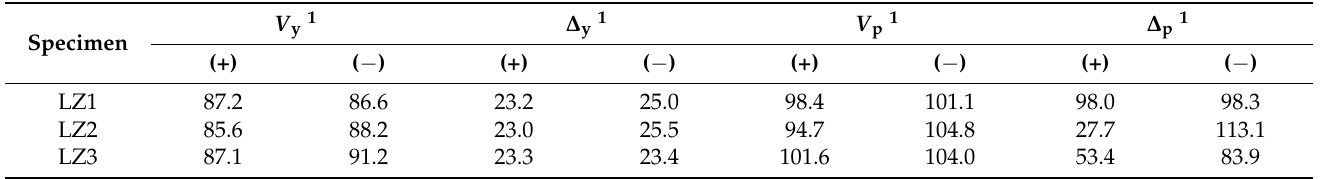
Table 2. Main test